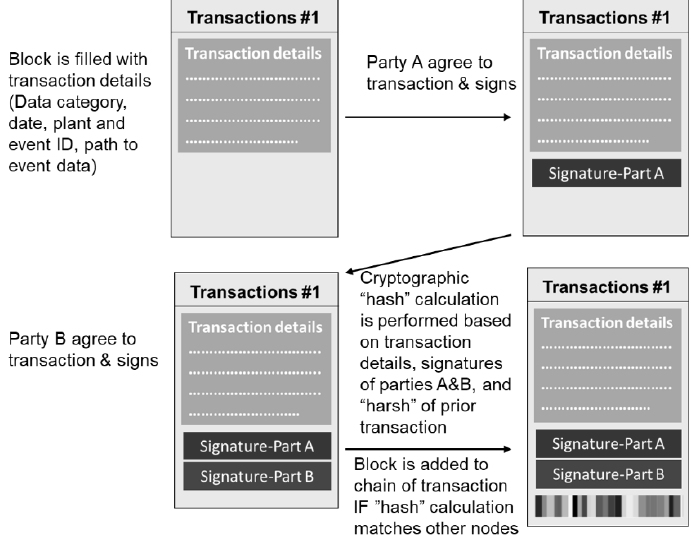
Figure 7. Illustration of how a single block in the blockchain is built and validated. Source: Goldman Sachs Global Investment